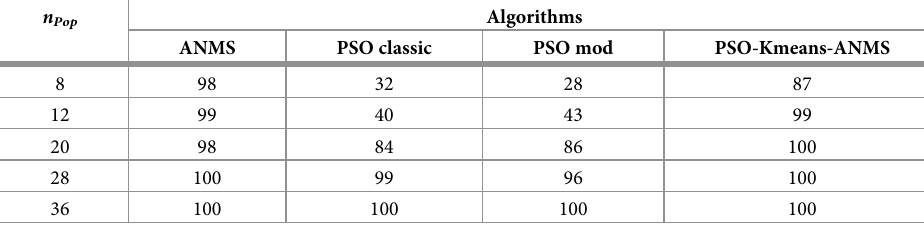
Table 4. Population versus success rate for the Rosenbrock function. Percentage success rate sr (%) for each algo- rithm referring to swarm sizes with 8, 12, 20, 28 and 36 particles. n Pop